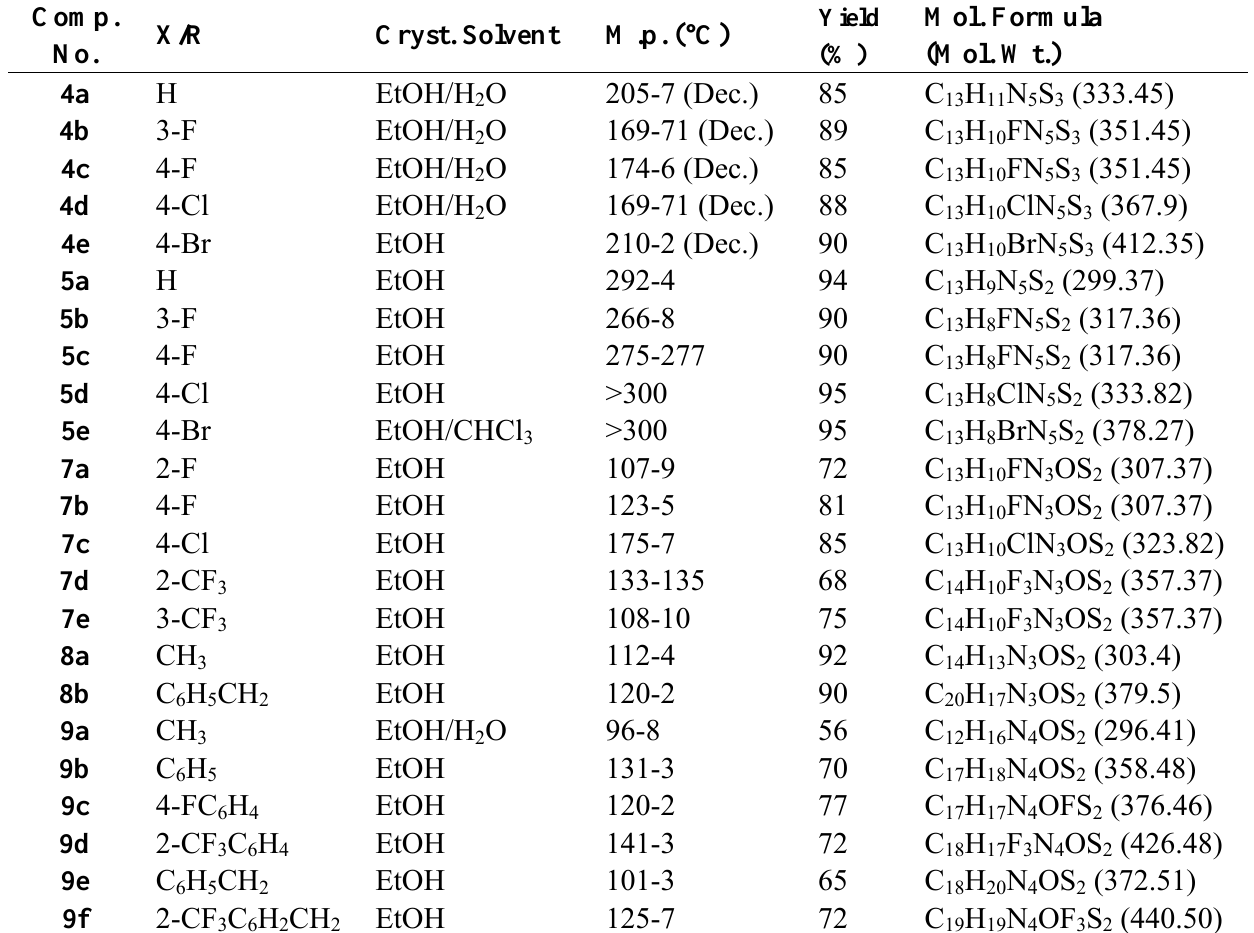
Table 1. Crystallization solvents, melting points, yield percentages, molecular formulae, and molecular weights of compounds 4a–e , 5a–e , 7a–e , 8a, b and 9a–f .